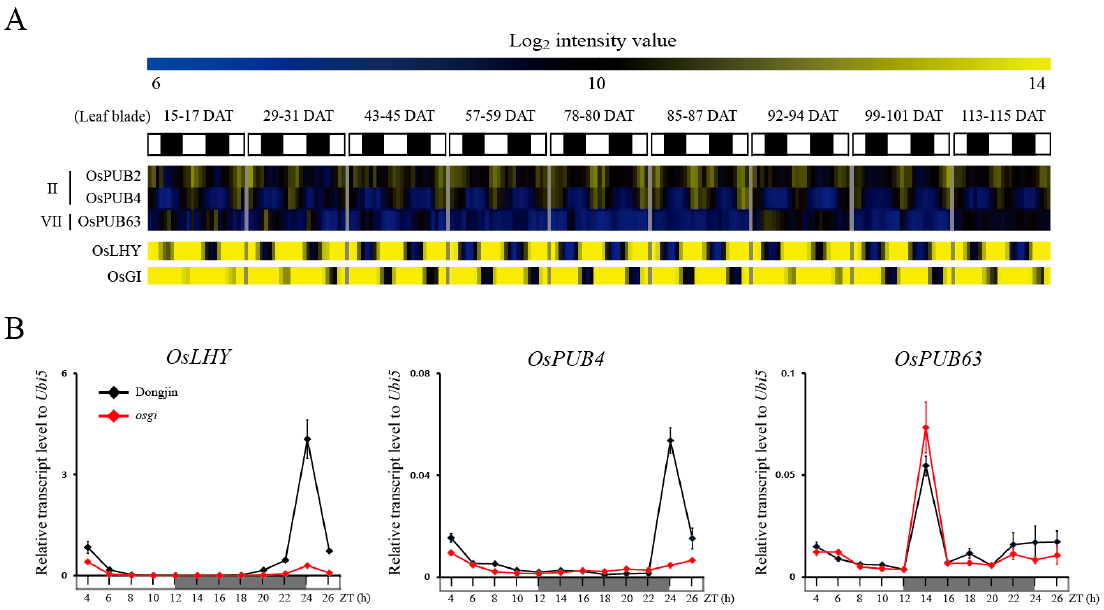
Figure 3. Diurnal expression patterns of two OsPUB genes in mature leaves, using available Agilent 44k array data over the entire plant life span ( A ), or evaluated at 12 time points over 24-h period in “Dongjin” rice and osgi mutant ( B ). OsLHY was standard marker gene for diurnal rhythm. OsUbi5 was served as the internal control. The continuous white and black bars indicate day and night time, respectively. ZT, zeitgeber time (ZT = 0 at lights-on).